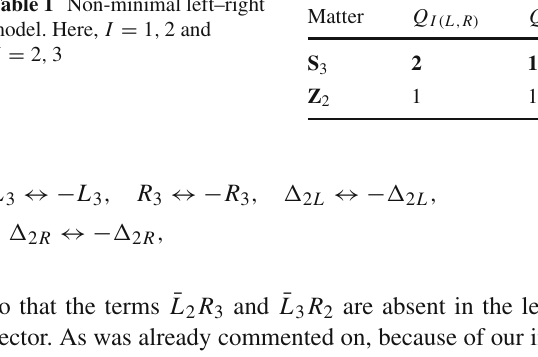
Table 1 Non-minimal left–right model. Here, I = 1 , 2